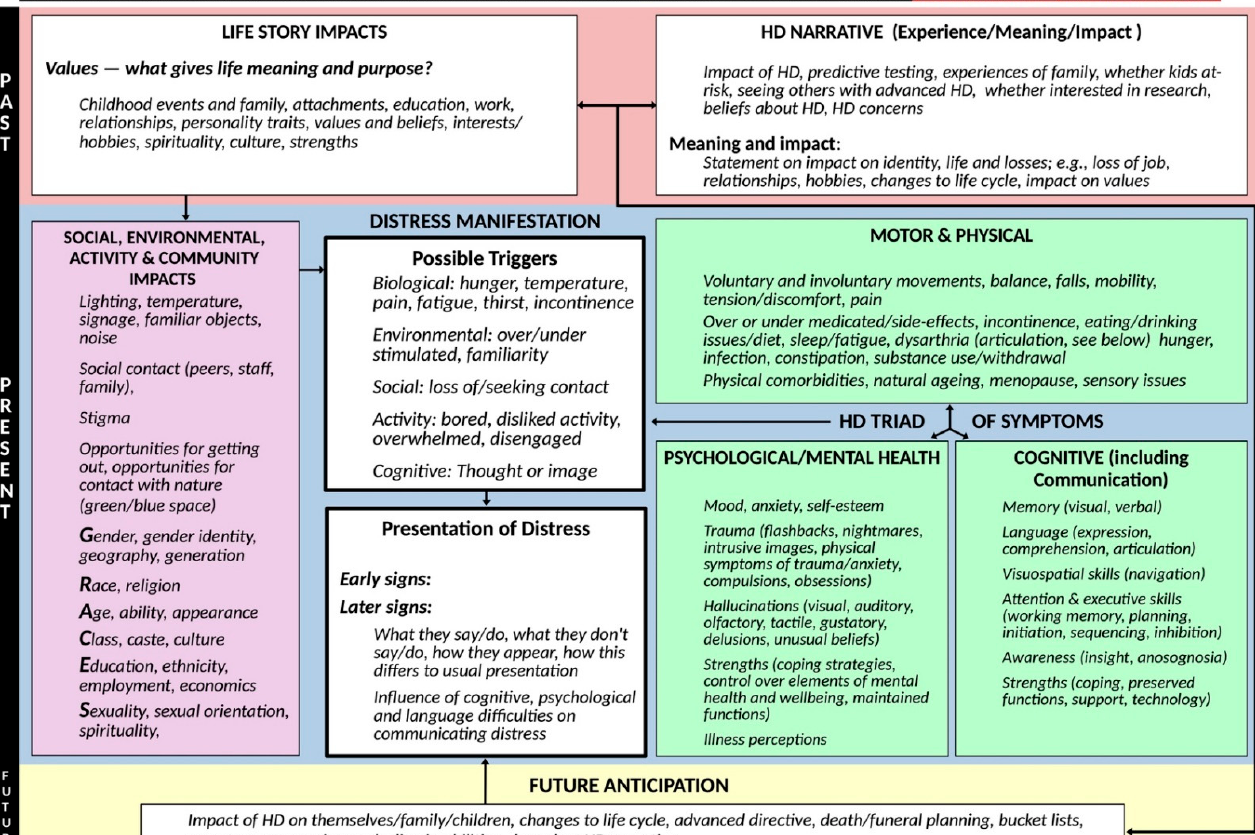
Figure 1. Template formulation model (prompts for completion in italics).